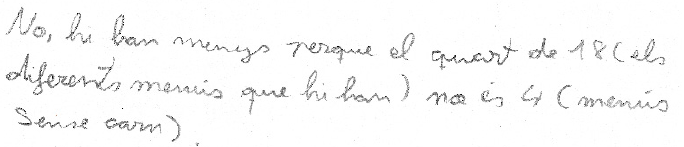
Figure 12. Partially correct answer of Q5. Student does not specify ¼ of 18 (translation: no, there are